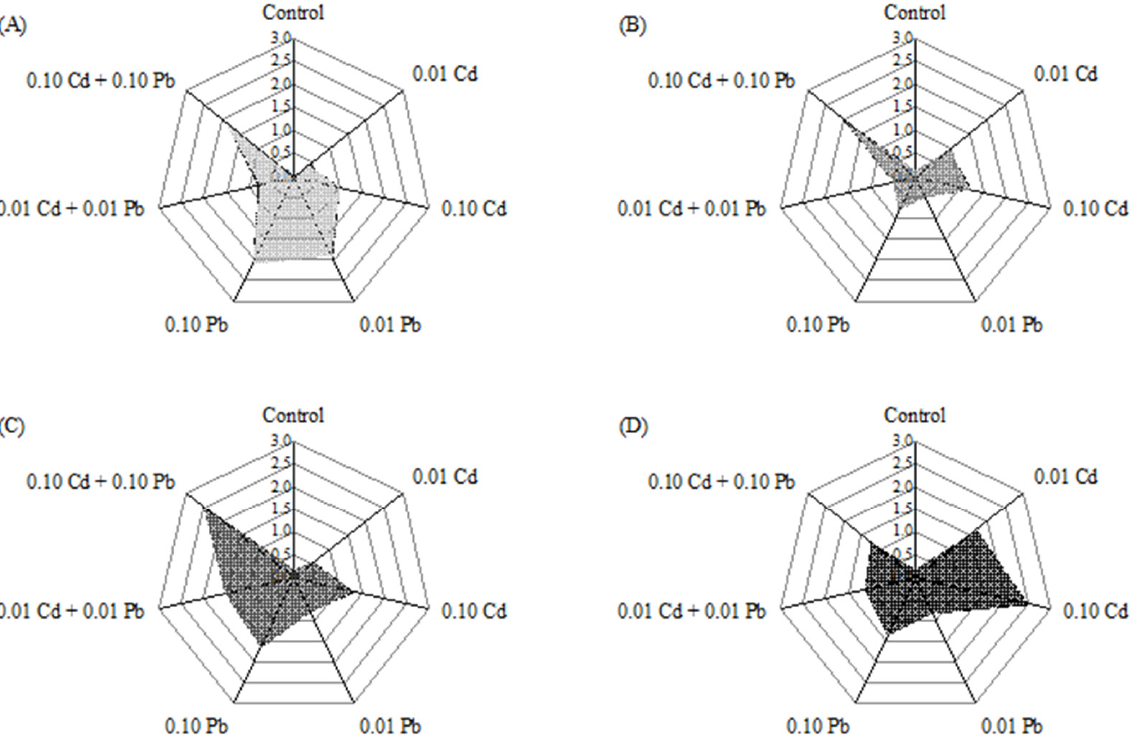
Figure 4. Integrated biomarker response (IBR) of all biomarkers measured in the hepatopancreas of M. nipponense for different exposure protocols; ( A ): 7 d, ( B ): 14 d, ( C ): 21 d and ( D ): 28 d.